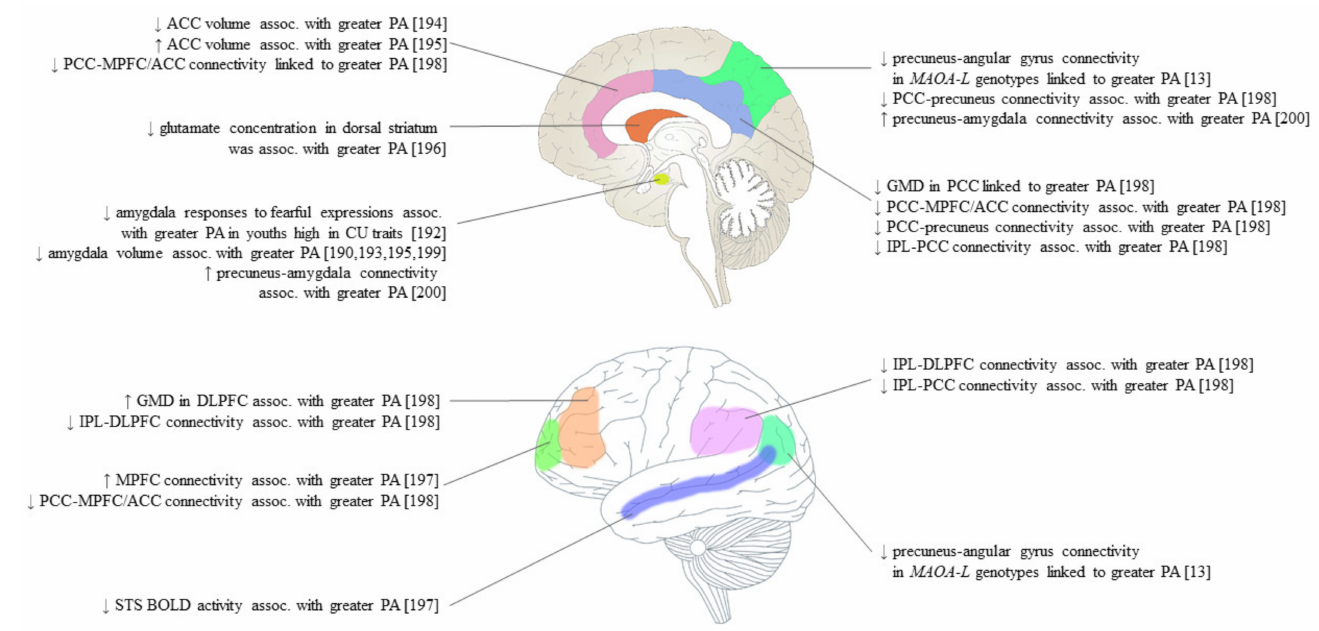
Figure 2. Neuroimaging findings of proactive aggression (PA), as quantified by the Reactive–Proactive Questionnaire [11], grouped by brain region. ACC, anterior cingulate cortex; Assoc., associated; PCC, posterior cingulate cortex; MPFC, medial prefrontal cortex; CU, callous–unemotional; MAOA-L, monoamine oxidase A low-activity genotype; GMD, grey matter density; IPL, inferior parietal lobe; DLPFC, dorsolateral prefrontal cortex; STS, superior temporal sulcus; BOLD, blood oxygenation